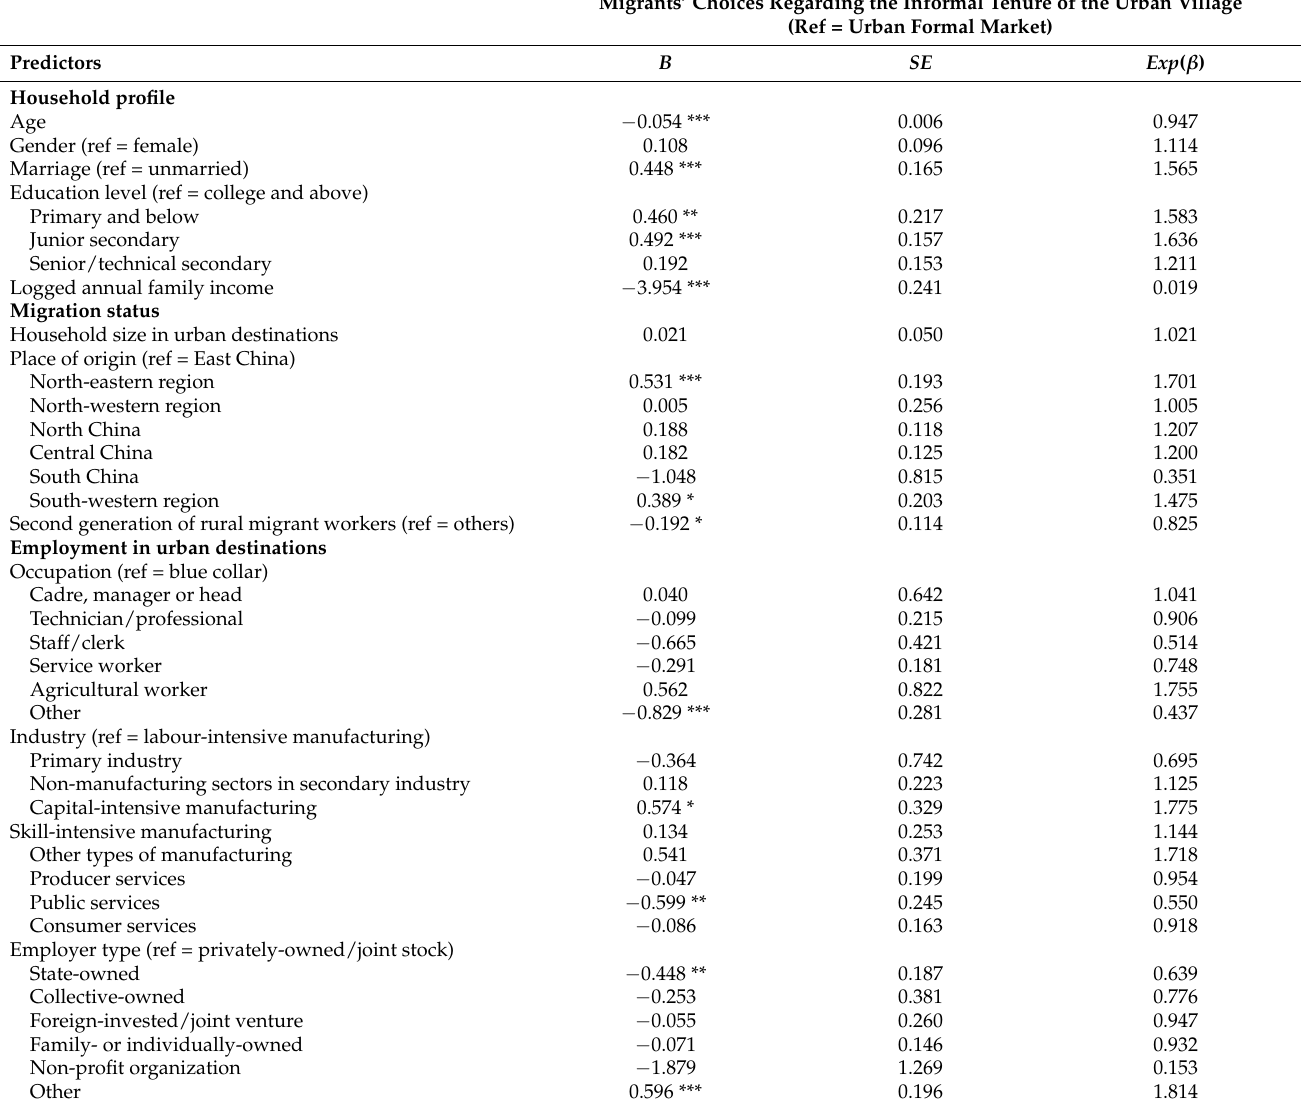
Table 2. Binary logistic regression of the migrants’ choices of the Beijing urban village,